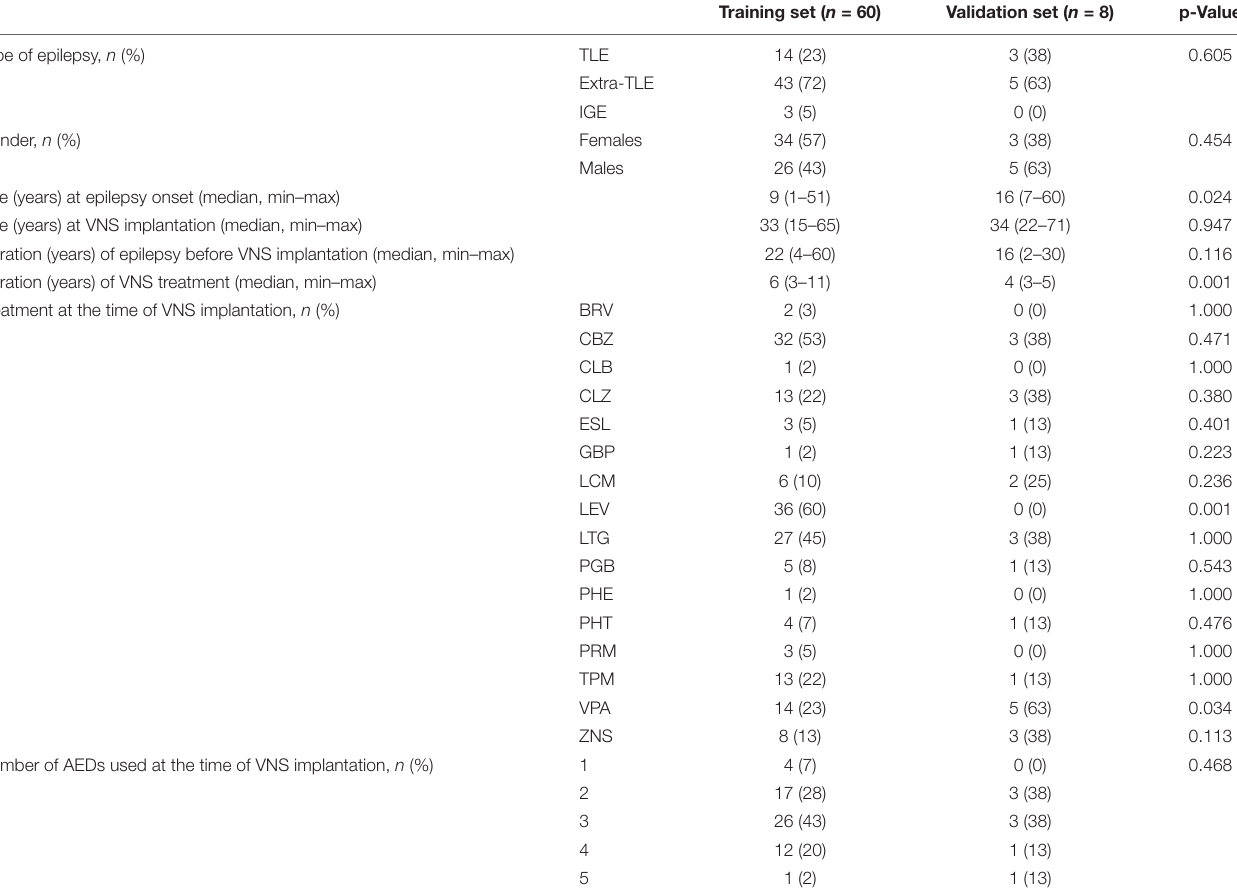
TABLE 1 | Demographic and treatment data for the training and validation